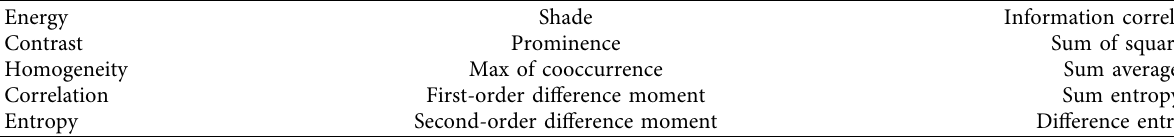
Table 3: List of the second-order statistics features.